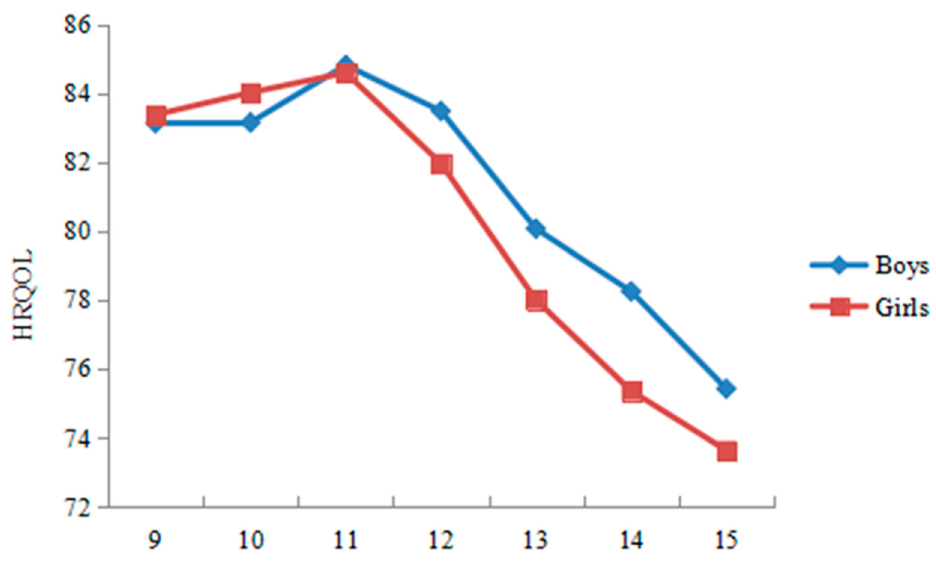
Figure 2. The total score of health-related quality of life by age and gender.